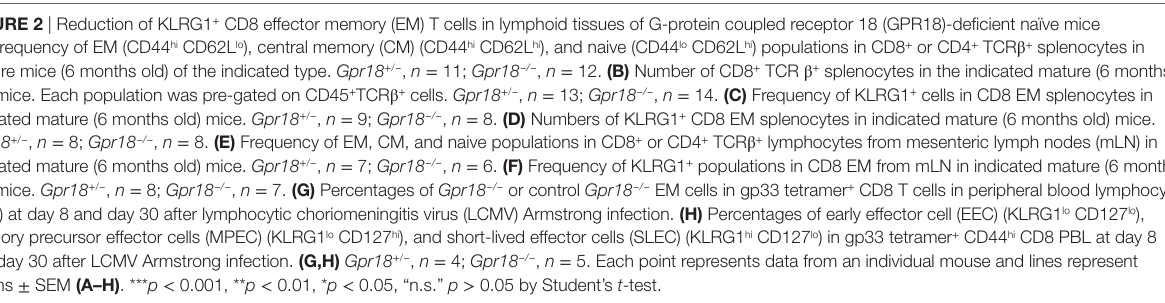
FigUre 2 | Reduction of KLRG1 + CD8 effector memory (EM) T cells in lymphoid tissues of G-protein coupled receptor 18 (GPR18)-deficient naïve mice (a) Frequency of EM (CD44 hi CD62L lo ), central memory (CM) (CD44 hi CD62L hi ), and naive (CD44 lo CD62L hi ) populations in CD8 + or CD4 + TCR β + splenocytes in mature mice (6 months old) of the indicated type. Gpr18 + / − , n = 11; Gpr18 − / − , n = 12. (B) Number of CD8 + TCR β + splenocytes in the indicated mature (6 months old) mice. Each population was pre-gated on CD45 + TCR β + cells. Gpr18 + / − , n = 13; Gpr18 − / − , n = 14. (c) Frequency of KLRG1 + cells in CD8 EM splenocytes in indicated mature (6 months old) mice. Gpr18 + / − , n = 9; Gpr18 − / − , n = 8. (D) Numbers of KLRG1 + CD8 EM splenocytes in indicated mature (6 months old) mice. Gpr18 + / − , n = 8; Gpr18 − / − , n = 8. (e) Frequency of EM, CM, and naive populations in CD8 + or CD4 + TCR β + lymphocytes from mesenteric lymph nodes (mLN)